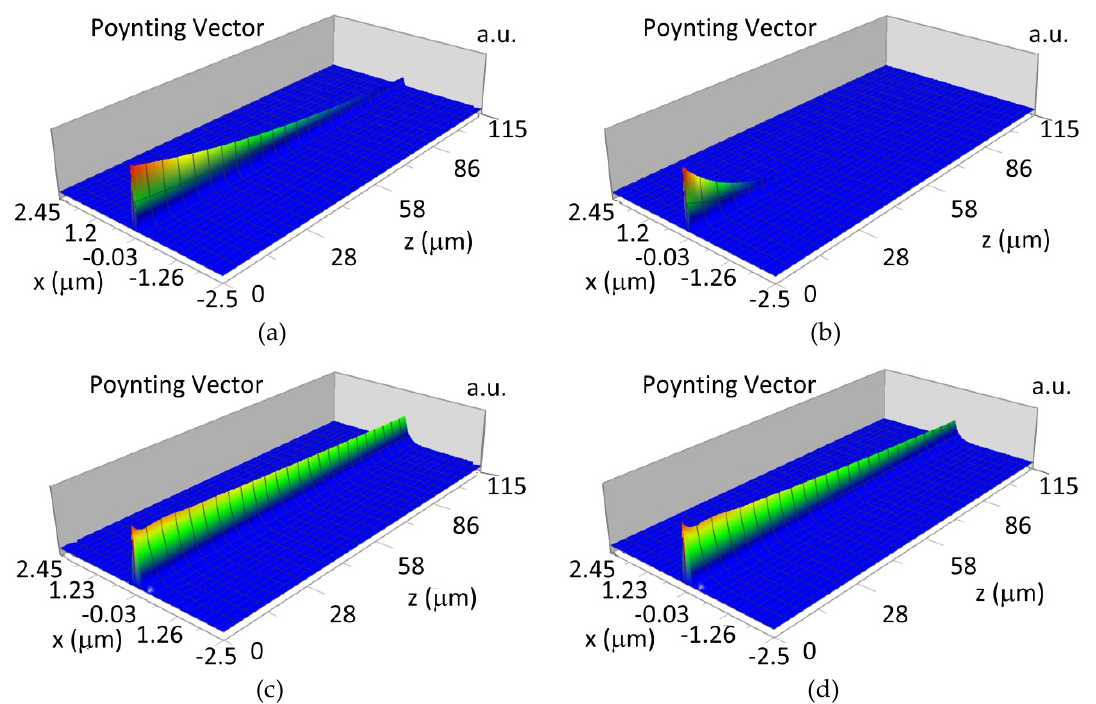
Figure 11. Propagation light in single-mode waveguide structure for TE00, d w = 32 nm (Poynting vector): ( a ) λ = 436 nm, Hb O2 , ( b ) λ = 436 nm, Hb, ( c ) λ = 560 nm, Hb O2 , ( d ) λ = 560 nm, Hb.